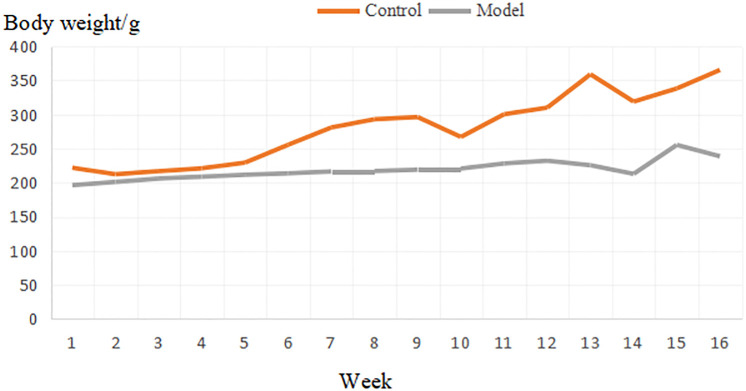
Mass variation diagram of the control group and model group.